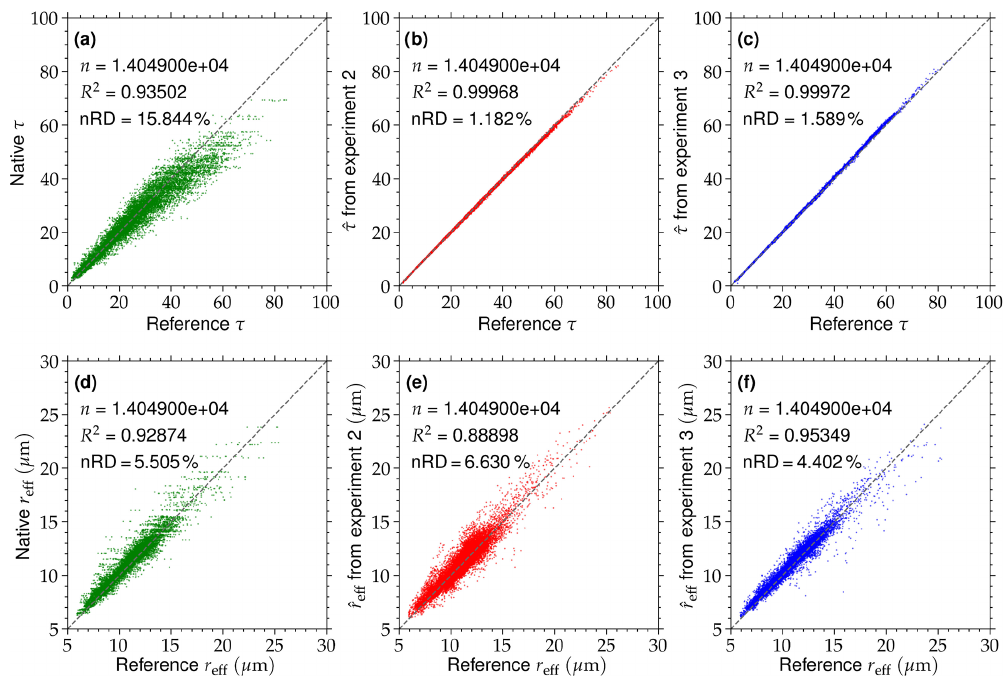
Figure 7. (a) Retrieved cloud optical thickness ( τ ) at SEVIRI’s native LRES as a function of the reference results ( τ derived from the remapped MODIS reflectances at the HRES scale of ≈ 1km). Data are from example scene 2, sampled on 9 June 2013 at 10:55UTC. The dashed gray line represents the 1 : 1 line. The number of samples ( n ), explained variance ( R 2 ), and normalized root-mean-square deviation (nRD; defined as the RD between the two data sets, normalized by the average reference τ ) are given. (b) – (c) Same as (a) but for the comparison between τ and the downscaling results ( ˆ τ ) from experiments 2 (constant reflectance ratio approach) and 3 (adjusted lookup table approach with LUT slope adjustment), respectively. (d) – (f) Same as (a) – (c) but for the effective droplet radius ( r eff and ˆ r eff